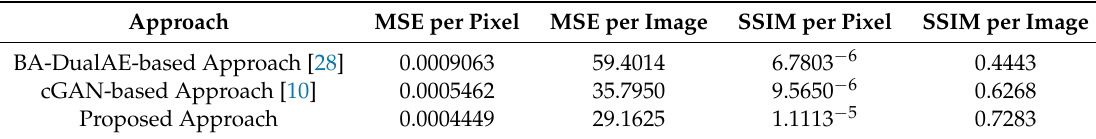
Table 2. MSE and SSIM based on reconstructing input test samples using the Cityscapes dataset